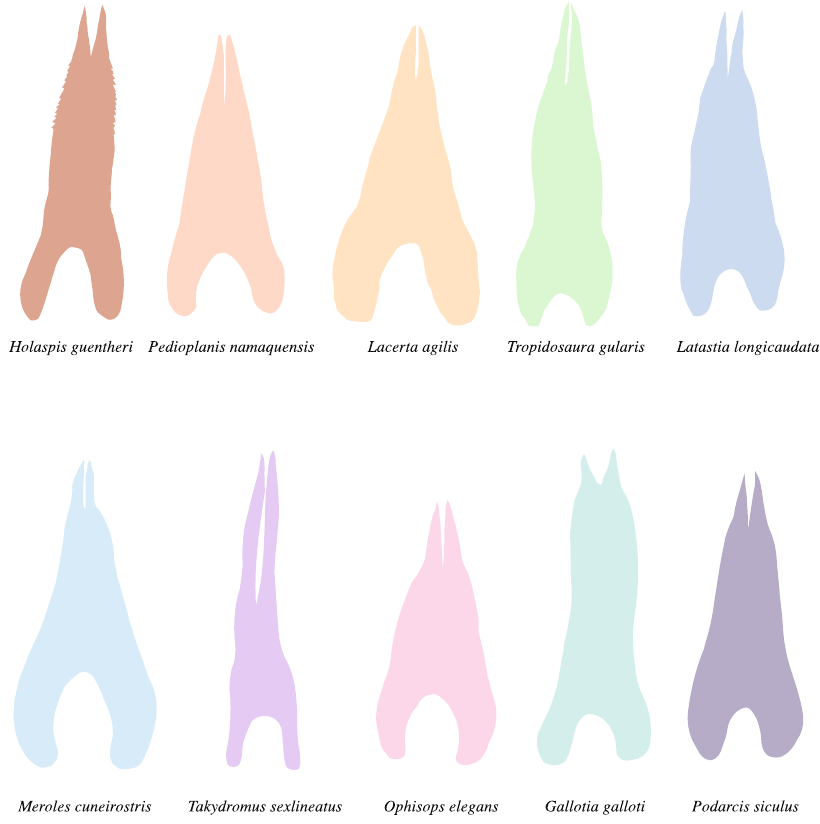
Figure 1. Illustration of the tongue form of ten lacertid lizards implemented in our study. All tongues are scaled to their head length (except Takydromus , which should be 43% smaller than